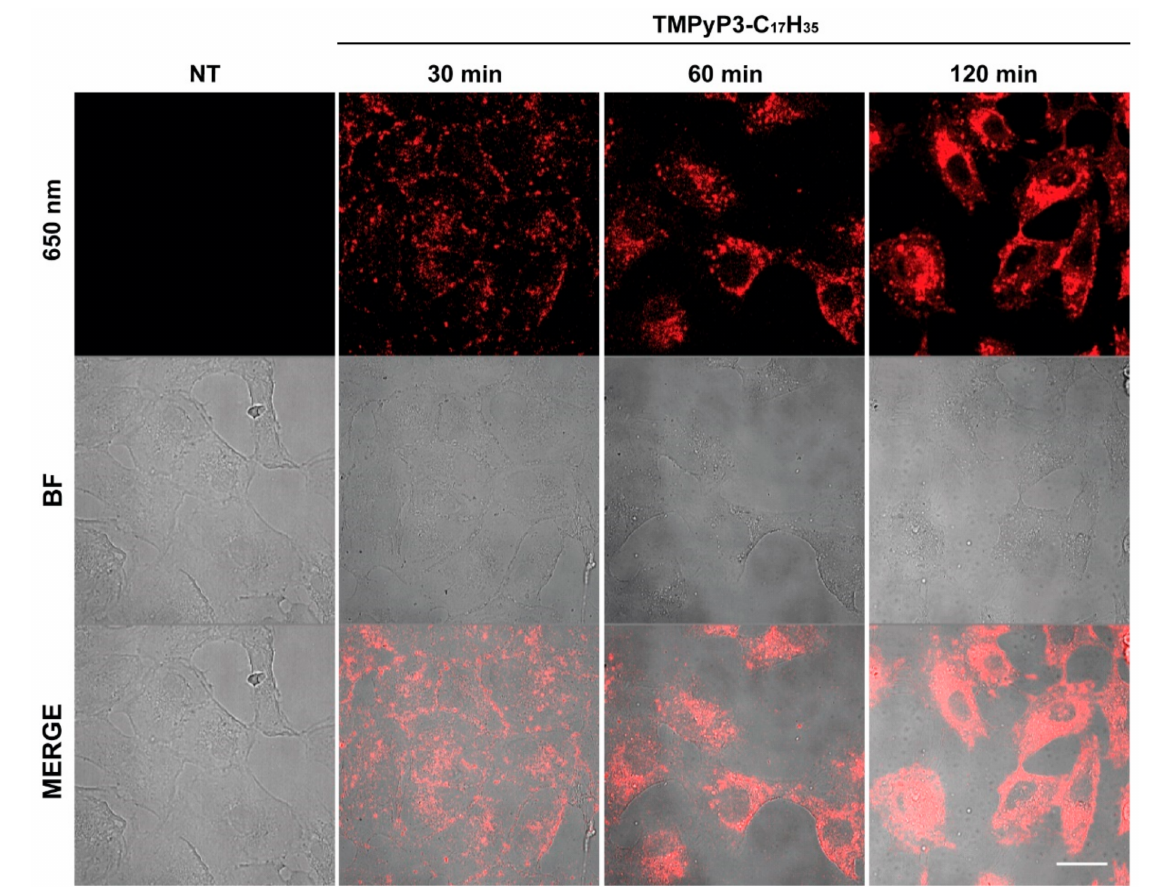
Figure 2. Internalization of TMPyP3-C 17 H 35 in Vero cells. Vero cells were mock treated or treated with 21 µ M TMPyP3-C 17 H 35 for indicated periods of time and analyzed by confocal laser scanning microscopy. Scale bar, 20 µ m. Upper panel emission at 650 nM. BF-bright